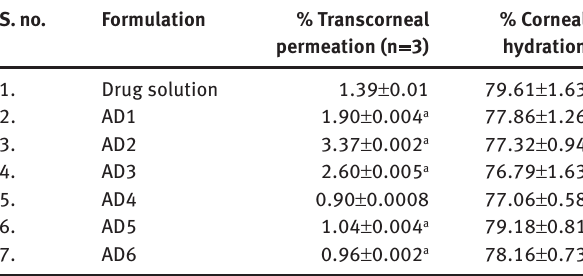
Table 3: Ex vivo transcorneal permeation and corneal hydration of different formulations and drug solution.